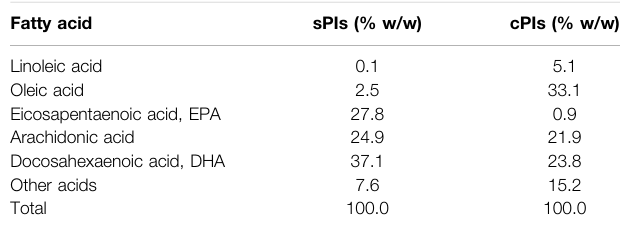
TABLE 2 | Composition of control and chicken derived Pls (0.01% w/w) containing pellet food.